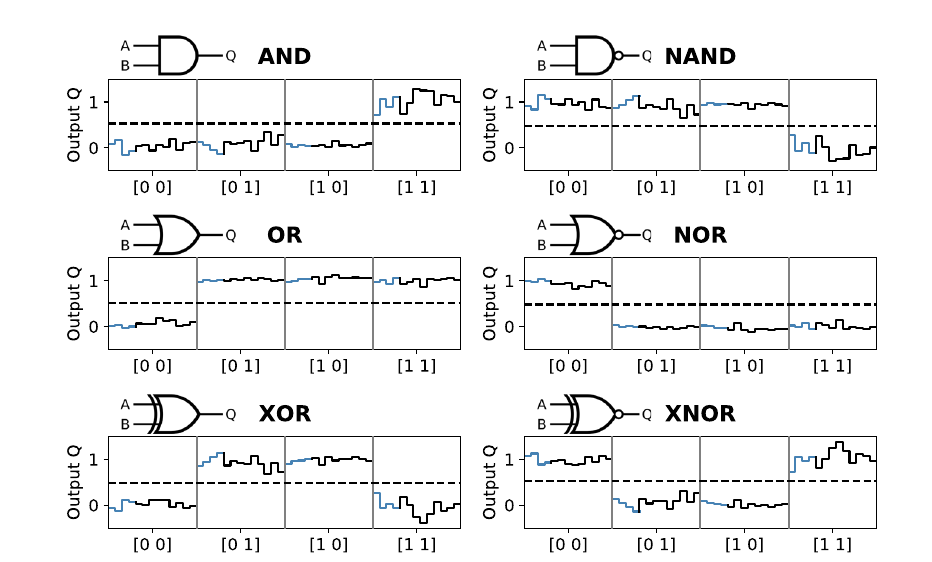
Fig. 3 | Logic operations. Outputs of the linear read-out optimized for different Booleanoperations.Foreachinputcombination([00],[01], [10],[1 1])the output Q of the linear read-out is shown for 13 sets of local skyrmion occurrence